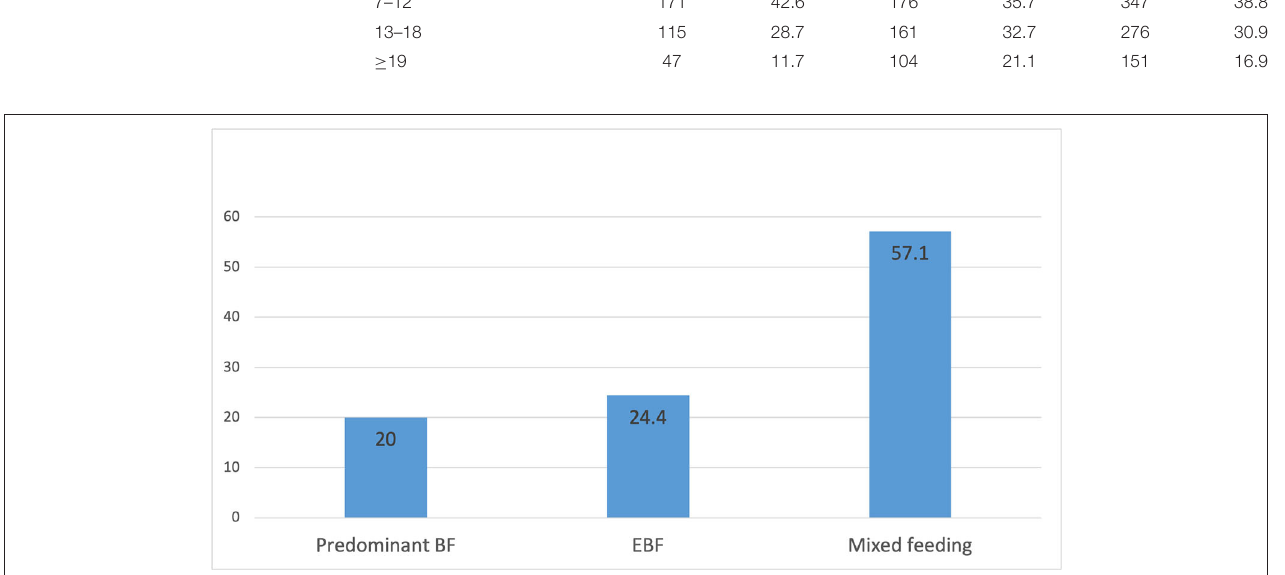
FIGURE 1 | Prevalence breastfeeding practices among women (predominant breastfeeding, exclusive breastfeeding and mixed feeding).